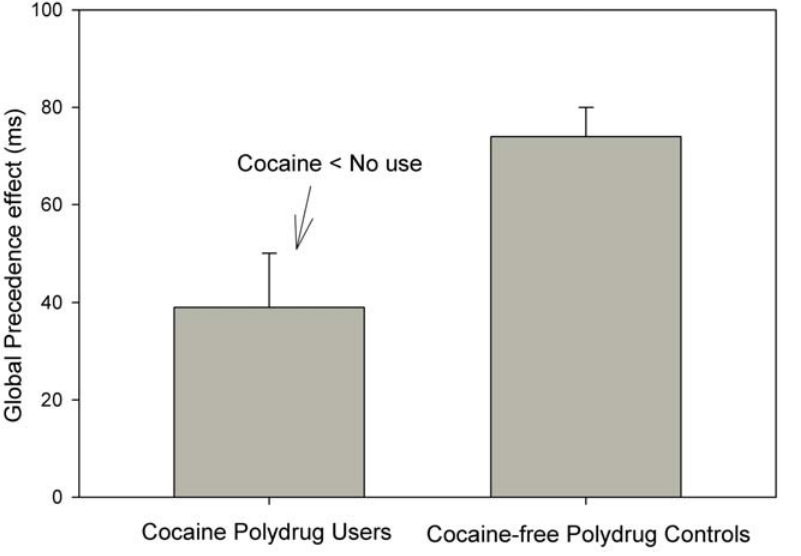
Figure 1. Mean Global Precedence effect for Cocaine Polydrug Users and Cocaine-free Polydrug Controls. Vertical capped lines atop bars indicate standard error of the mean.